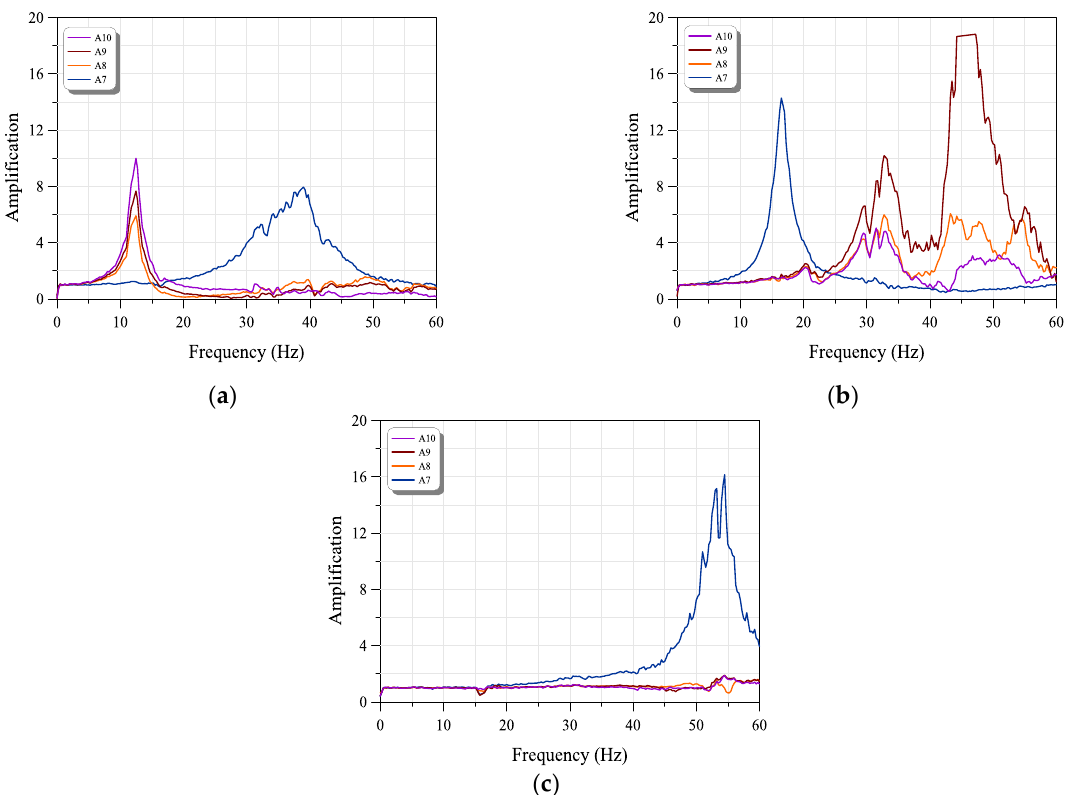
Figure 7. In-cabinet resonant-frequency test results: ( a ) side to side, ( b ) front to back, and ( c )